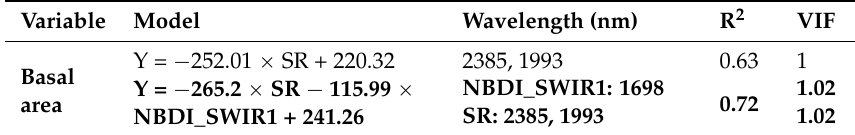
Table 4. Best performing simple and stepwise multiple regression models to predict basal